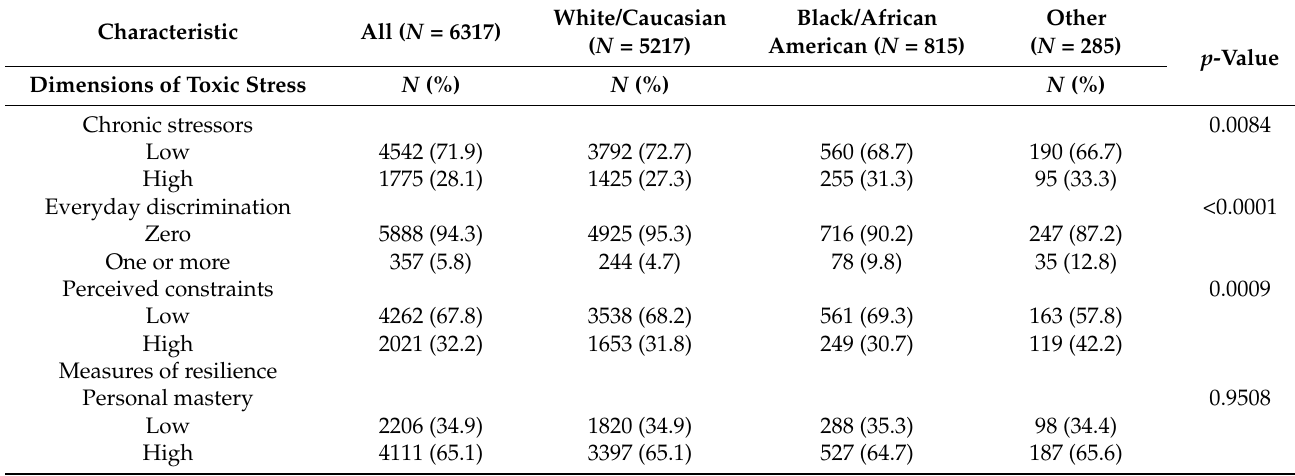
Table 2. Distribution of Toxic Stress and Resilience promoting factors among Older American adults enrolled in the HRS 2012–2014 sample at baseline by